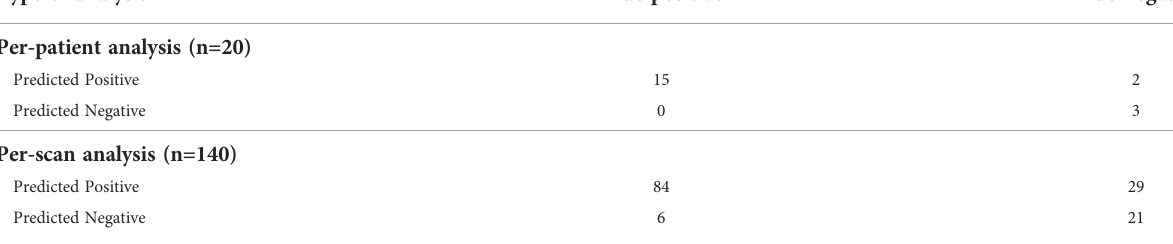
TABLE 2 Confusion matrix for lymph node